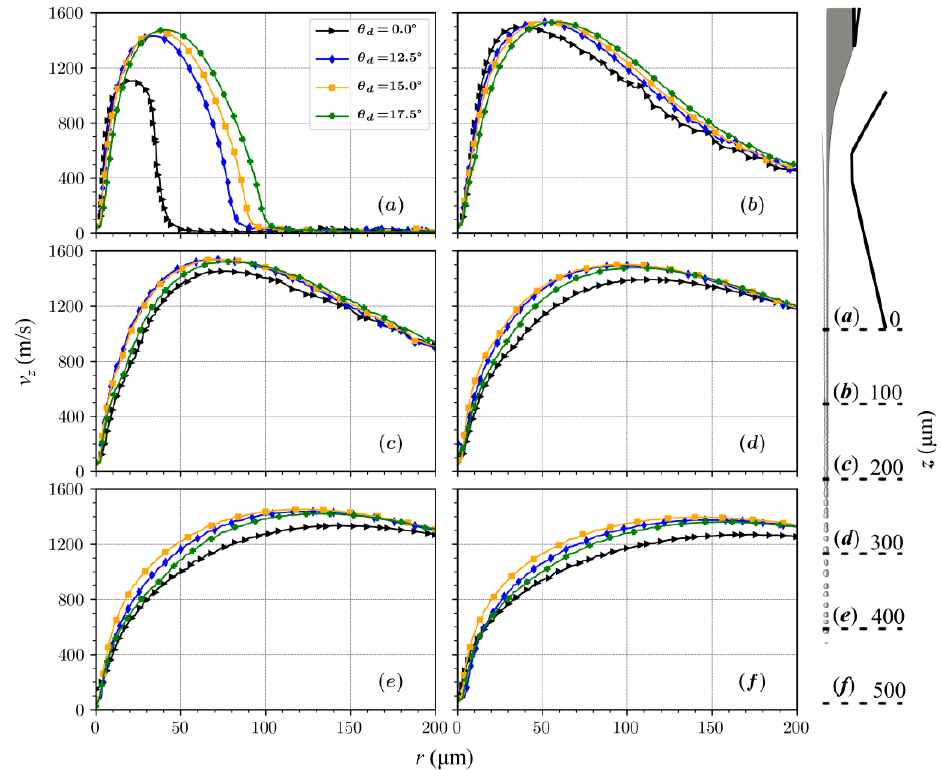
Figure 8. Axial component of velocity profile as a function of the radius at 6 axial positions for L d = 200 µm and diverging angles of 0°, 12.5°, 15°, and 17.5°.